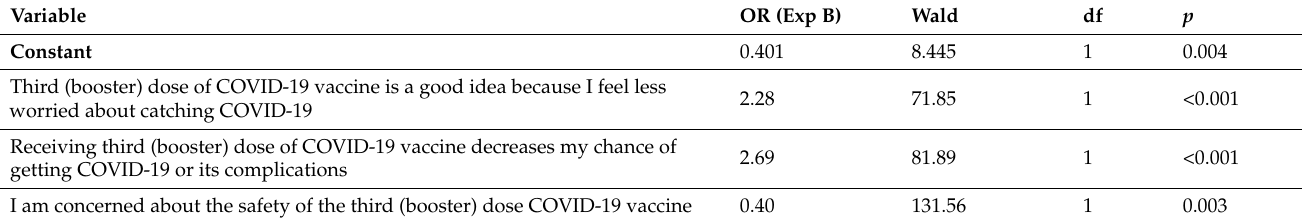
Table 5. HBM predictors of definite COVID-19 vaccine third dose (booster) uptake (binary logistic regression